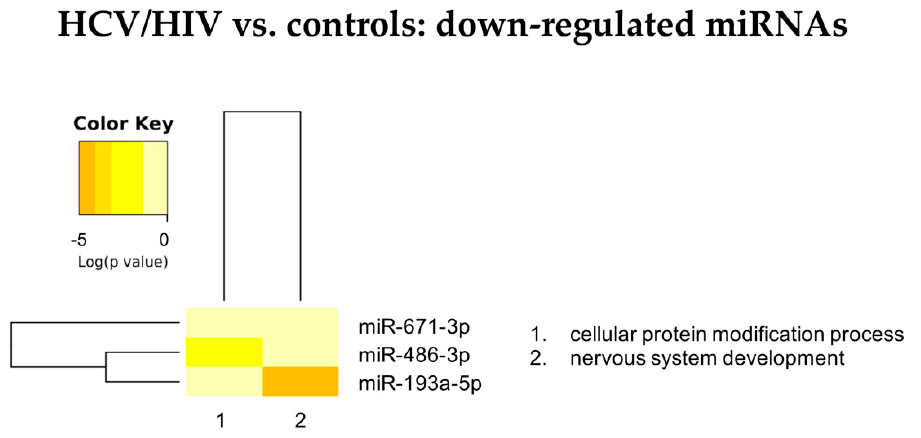
Figure 6. Heatmap showing the significance (see color key) of the association of down-regulated miRNAs with “Gene Ontology-Biological Process” categories, as identified applying the “Categories Union” method.